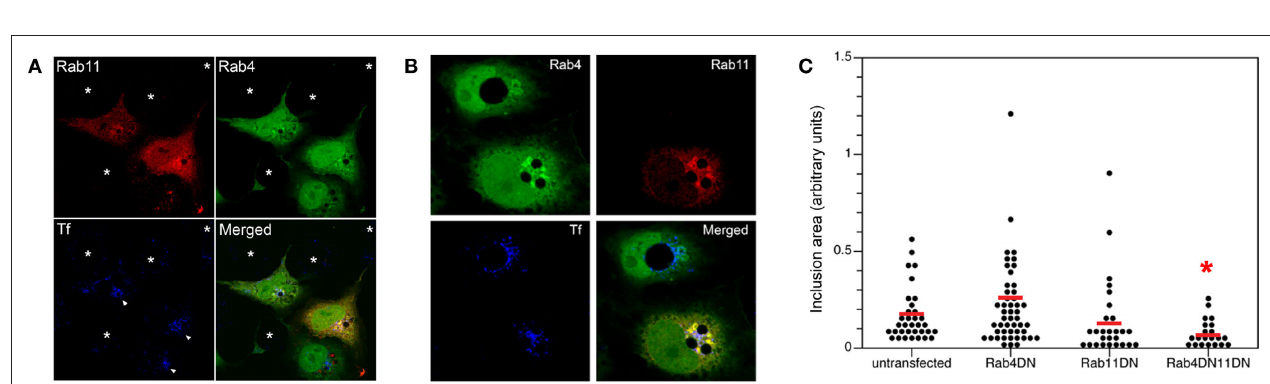
confocal images (A) and quantification (B) of co-localization of transferrin with individual markers in singly transfected cells in untreated or FR179254-treated conditions. Representative confocal images (C) and quantification (D) of co-localization of transferrin with indicated markers in doubly transfected cells.